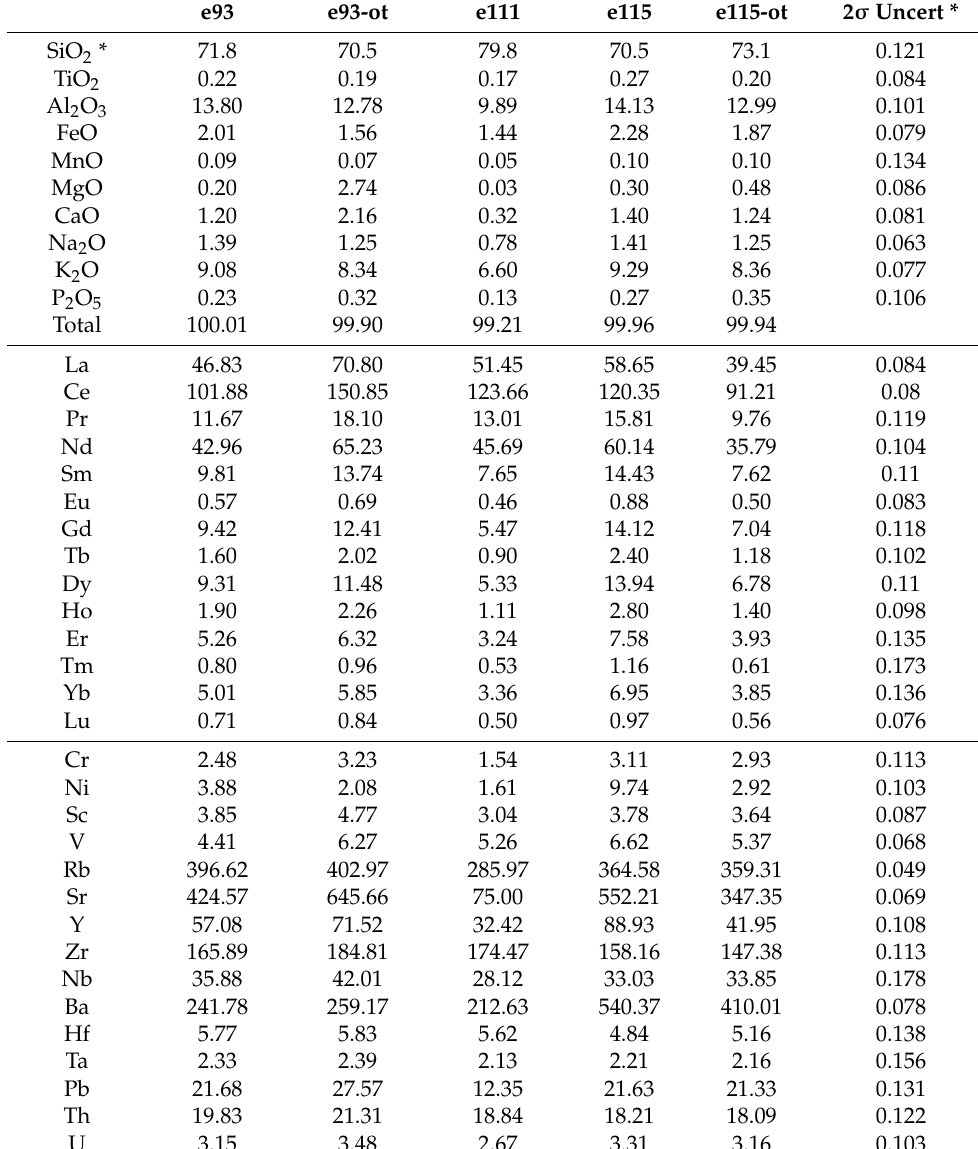
Table 5. ICP-MS whole-rock major and trace